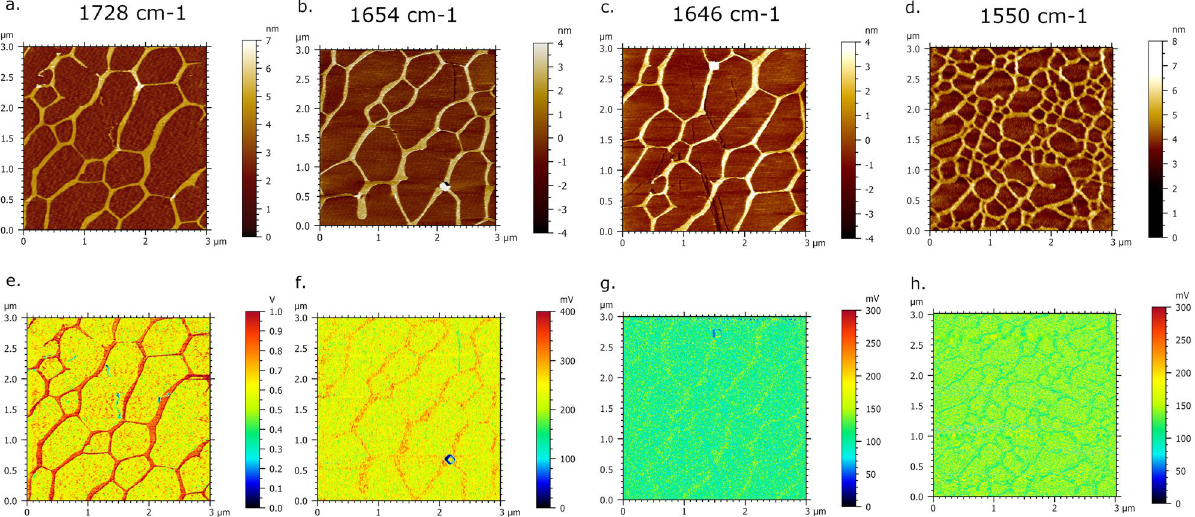
Figure 2. AFM-IR imaging of DNA network deposited onto spermidine-functionalized mica surface. ( a – d ) AFM topography images and corresponding. ( e – h ) IR absorption maps of DNA network with a highest contrast-absorption of DNA acquired at 1728 cm −1 , gradually attenuated at 1654 and 1646 cm −1 and highest contrast-absorption of background at 1550 cm −1